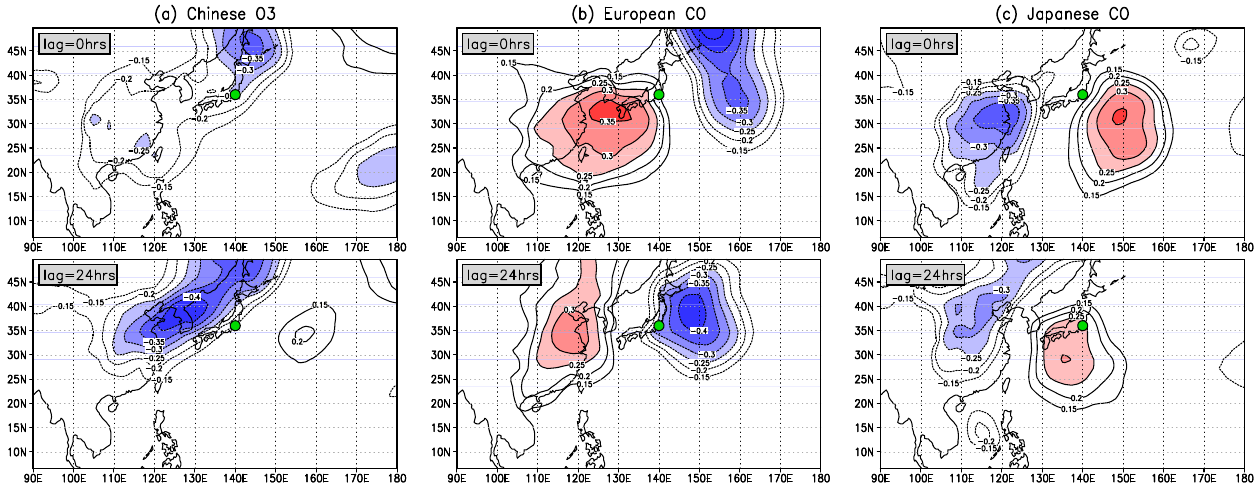
Fig. 11. Correlation between mean sea-level pressure and the contributions of (a) Chinese O 3 , (b) European CO and (c) Japanese CO over Tokyo (marked with a circle) in spring 2001. Positive correlations are highlighted in red and negative correlations in blue. Lower panels show the correlation coefficient lagged by 24 h, and thus the relationship with mean sea-level pressure one day earlier.